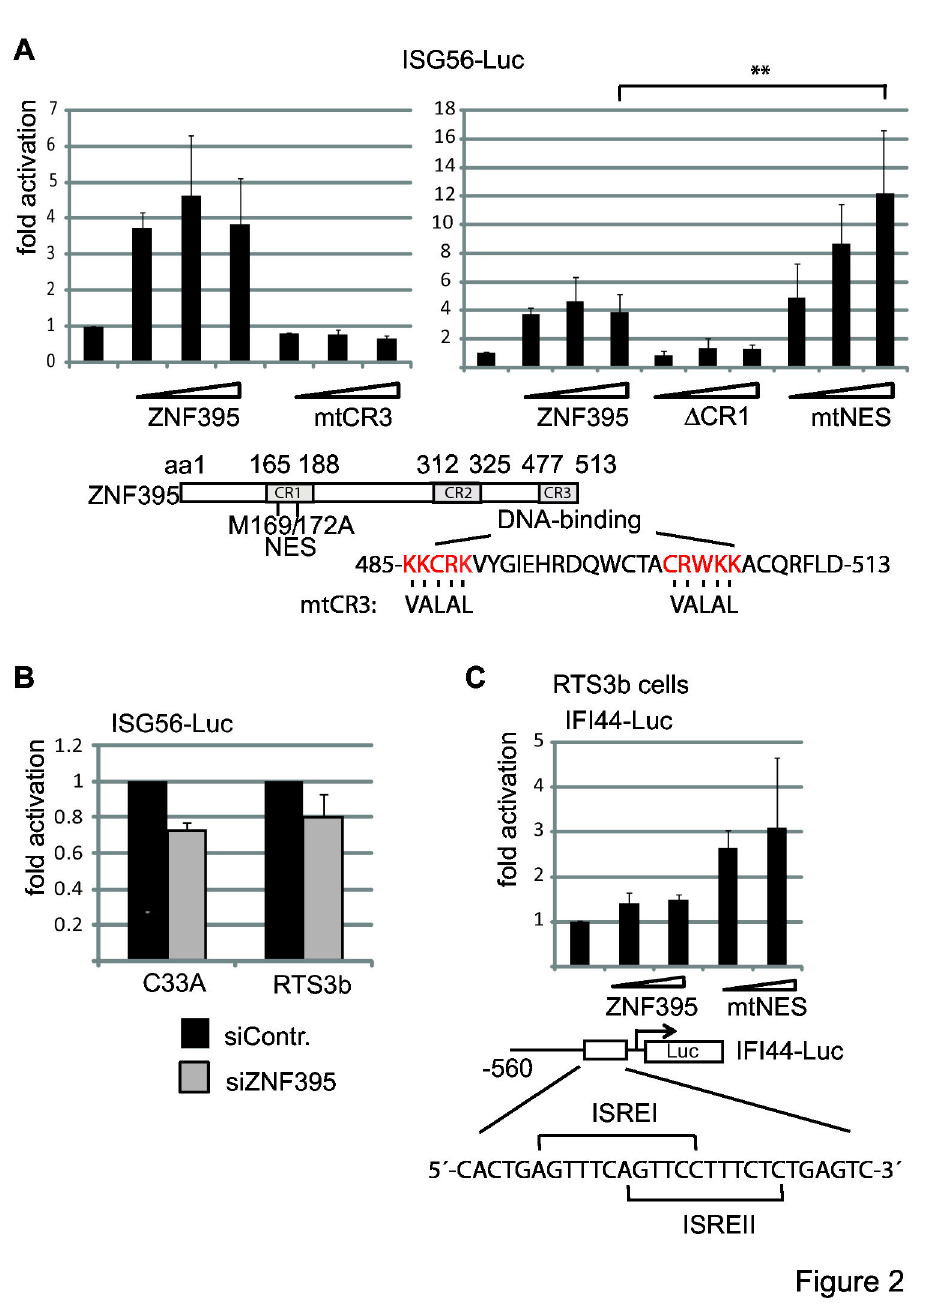
Figure 2. ZNF395 activates the ISG56 promoter and requires its DNA-binding domain and CR1. ( A ) RTS3b cells were seeded in six-well plates and transiently transfected with 500ng of the ISG56-Luc reporter construct and increasing amounts (5, 10, 20ng) of expression vector for FLAG-ZNF395 or the different mutants per well, as indicated. The structure of ZNF395 with its conserved regions CR1, CR2 and CR3 is depicted beneath the graphs including the sequence of the C-terminal 25 amino acids, which are conserved to the E-tail of TCF-1E and TCF-4E [52]. The M at pos. 169 and 172 were changed to A in mtNES while in ΔCR1 the amino acids from 165 to 188 were deleted. The amino acids that were mutated in mtCR3 and leading to loss of DNA- binding are indicated. ( B ) RTS3b and C33A cells were first transfected with siControl or siZNF395 and 24h later with the ISG56-Luc reporter construct. All graphs represent the results of at least three independent experiments. The standard deviations are given. ( C ) RTS3b cells were transiently transfected with the Luciferase reporter construct containing the IFI44-promoter including 560bp bases upstream of the initiation site. The segment harbors two overlapping ISREs, which have been shown to mediate the IFN- dependent induction of IFI44. The expression vector for ZNF395 and ZNF395mtNES were co-transfected as in A. doi: 10.1371/journal.pone.0074911.g002 PLOS ONE |